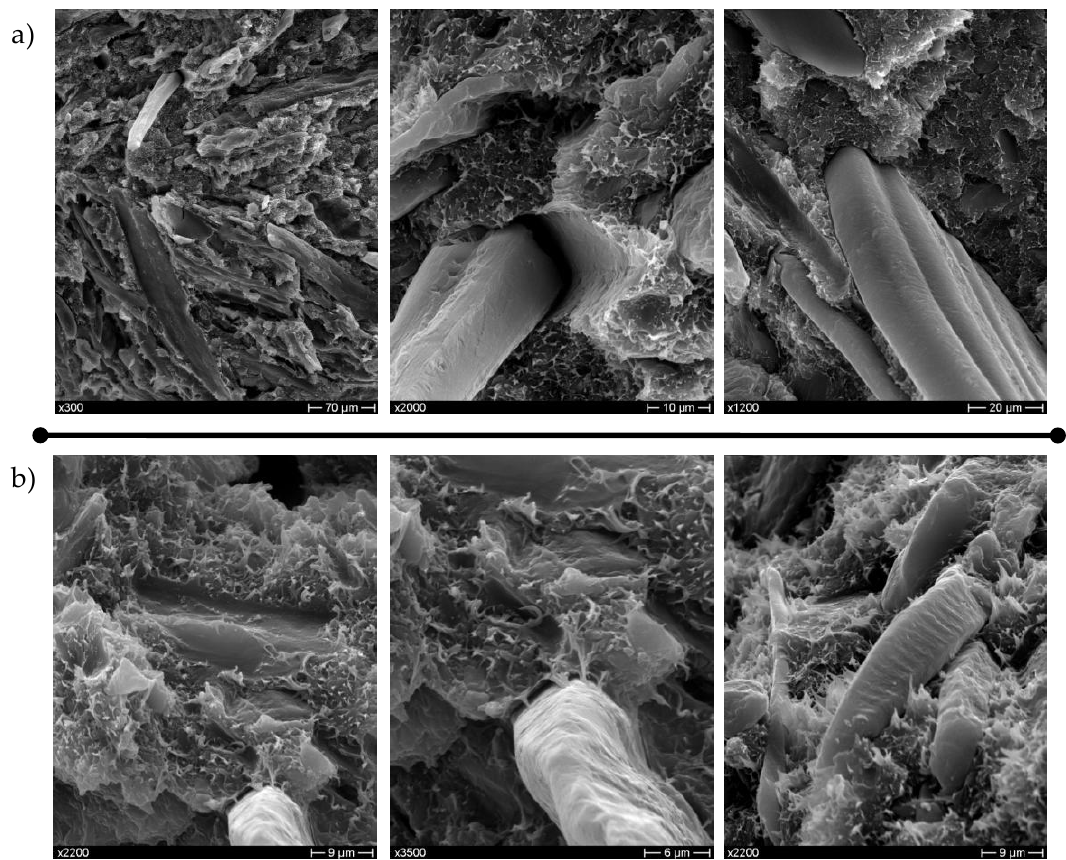
Figure 4. SEM micrographs of biocomposites with 30 wt % CSS in the as-received state ( a ) and with 30 wt % CSS after extraction ( b ) at different magnifications.